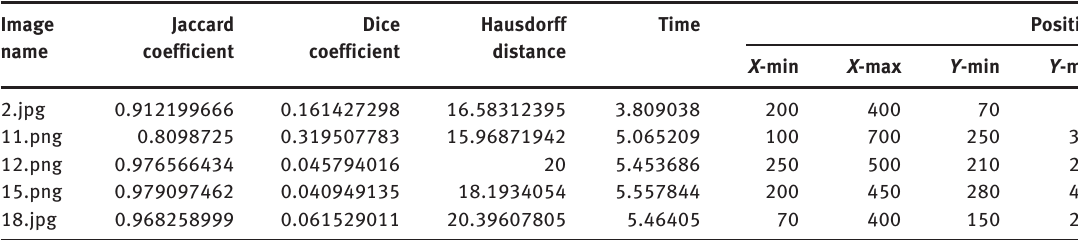
Table 2: Performance Analysis Using Existing GA.